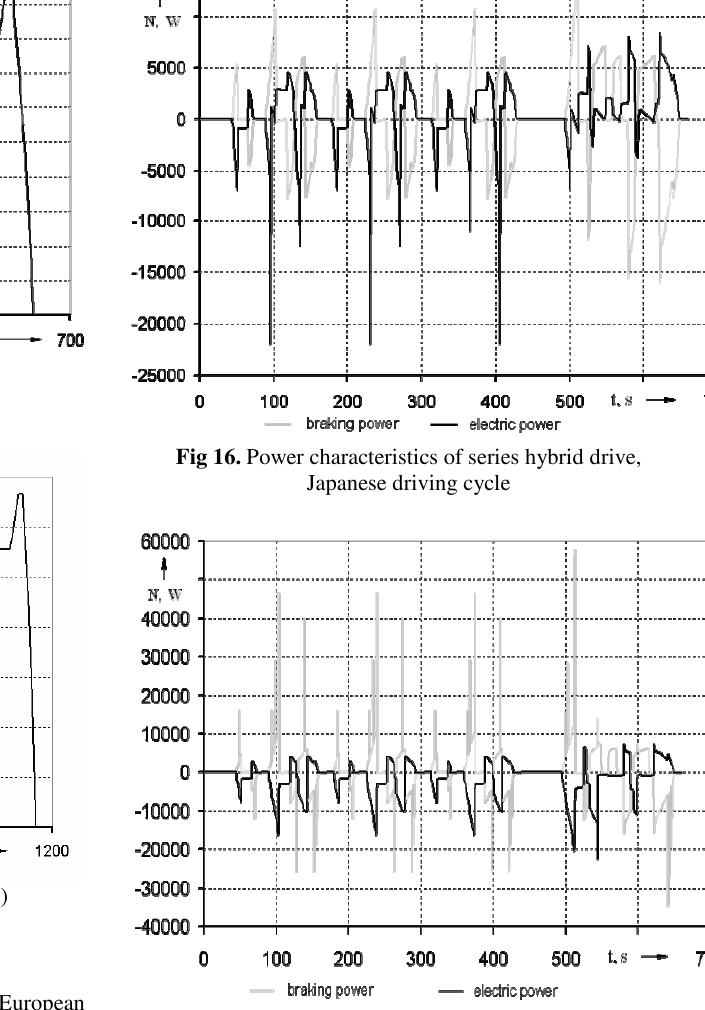
Driving cycle Japanese